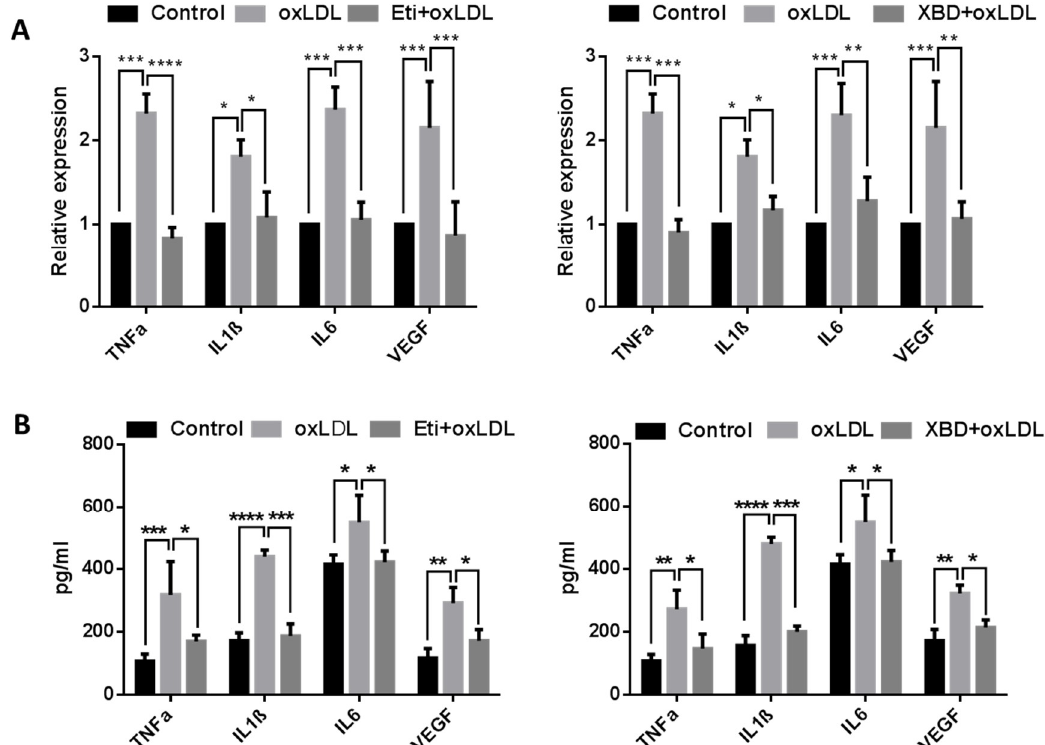
Figure 6. The expression of inflammation genes was quantified in RF/6A cells following treatment with oxLDL and TSPO ligands. ( A ) mRNA expression of TNF- α , IL1- β , IL-6 and VEGF relative to β -ACTIN was measured following treatment with oxLDL and compared to that seen in cells treated additionally with Etifoxine (20 µ M) or XBD173 (25 µ M) for 24 h and in vehicle-treated control cells. ( B ) Following the same treatment, the protein concentrations of these genes were measured by ELISA. Data are represented as mean ± SD and were analysed by Two-way ANOVA followed by Bonferroni multiple comparison test. * p < 0.05, ** p < 0.01, *** p < 0.001 and **** p < 0.0001.